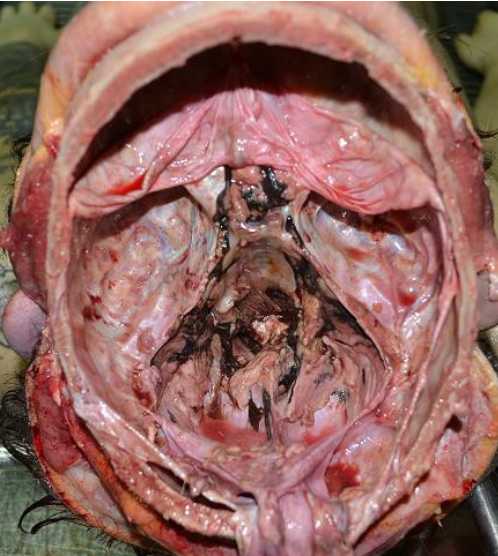
Figure 4. Skull base-posterior fossa and venous sinus examination showed a blackish